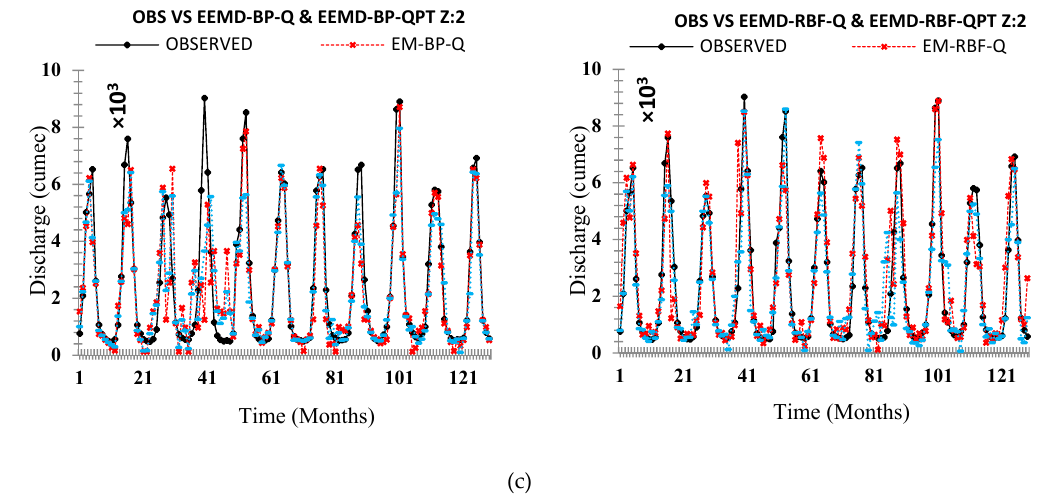
Figure 15. Comparison of the originally observed streamflow and the simulated runoff hydrograph Zone Two ( a ) OBS VS ANN (Q & QTP) Inputs, ( b ) OBS VS ANN-DWT (Q & QTP) Inputs, and ( c ) OBS VS ANN-EEMD (Q & QTP) Inputs.